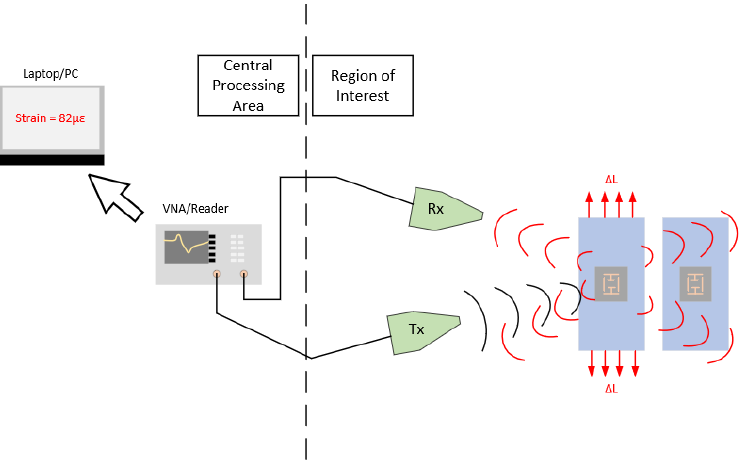
Figure 1. Envisaged system diagram.